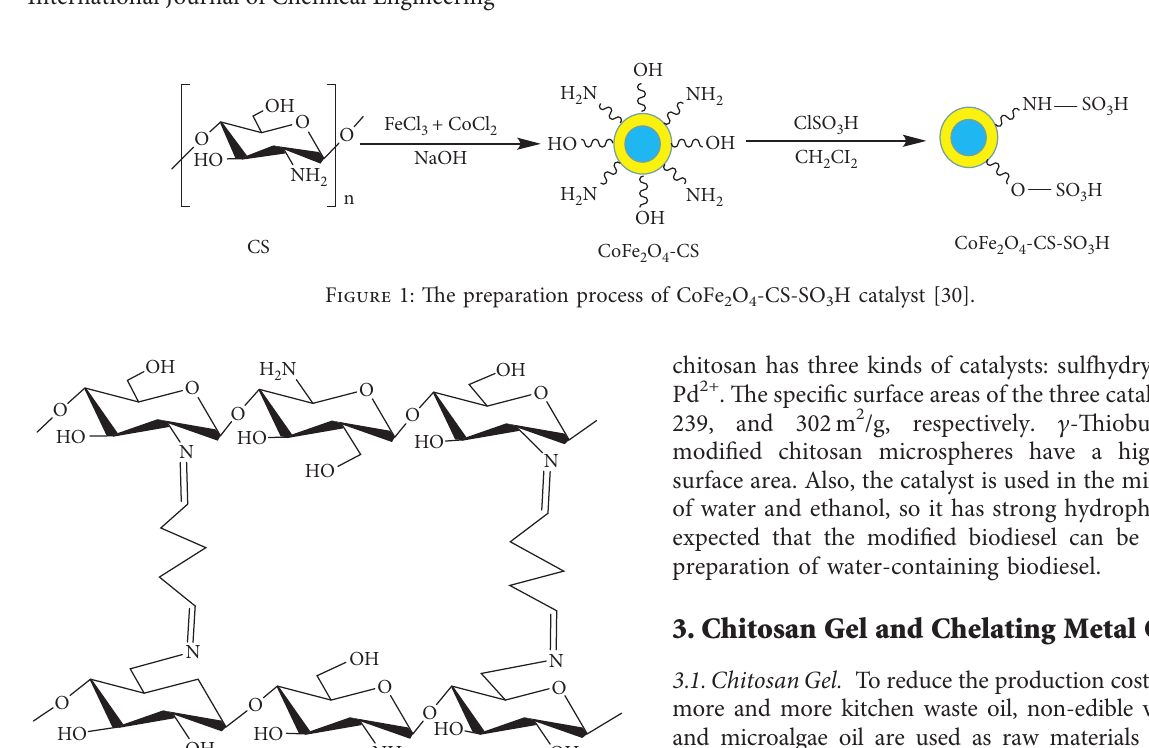
Figure 2: The microsphere formed by crosslinking chitosan and glutaraldehyde [33].